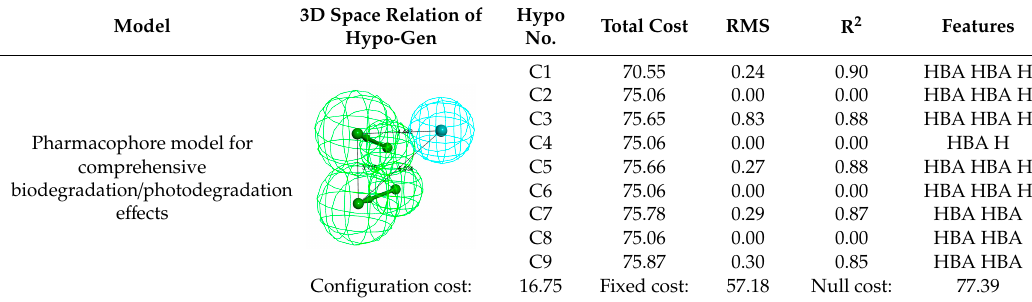
Table 2. Statistical parameters of the pharmacophore model for comprehensive biodegradation/photodegradation effects of OPFRs, constructed with Hypo-Gen.